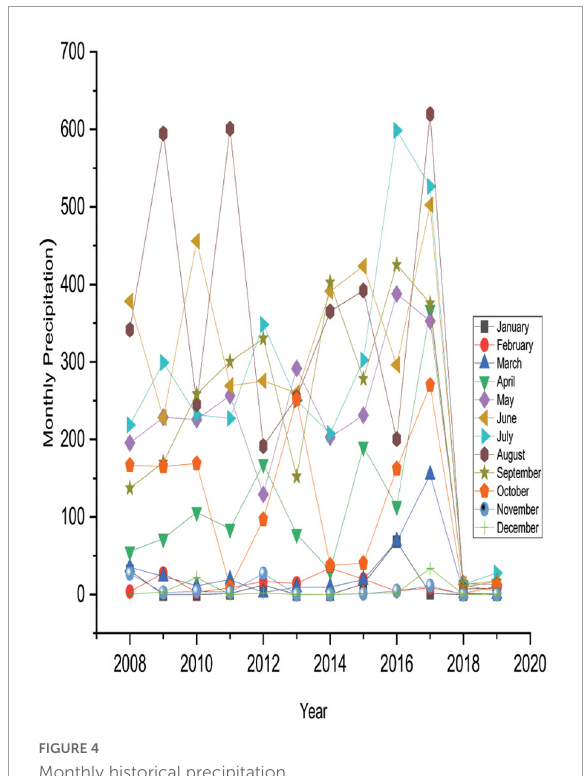
FIGURE4 Monthly historical